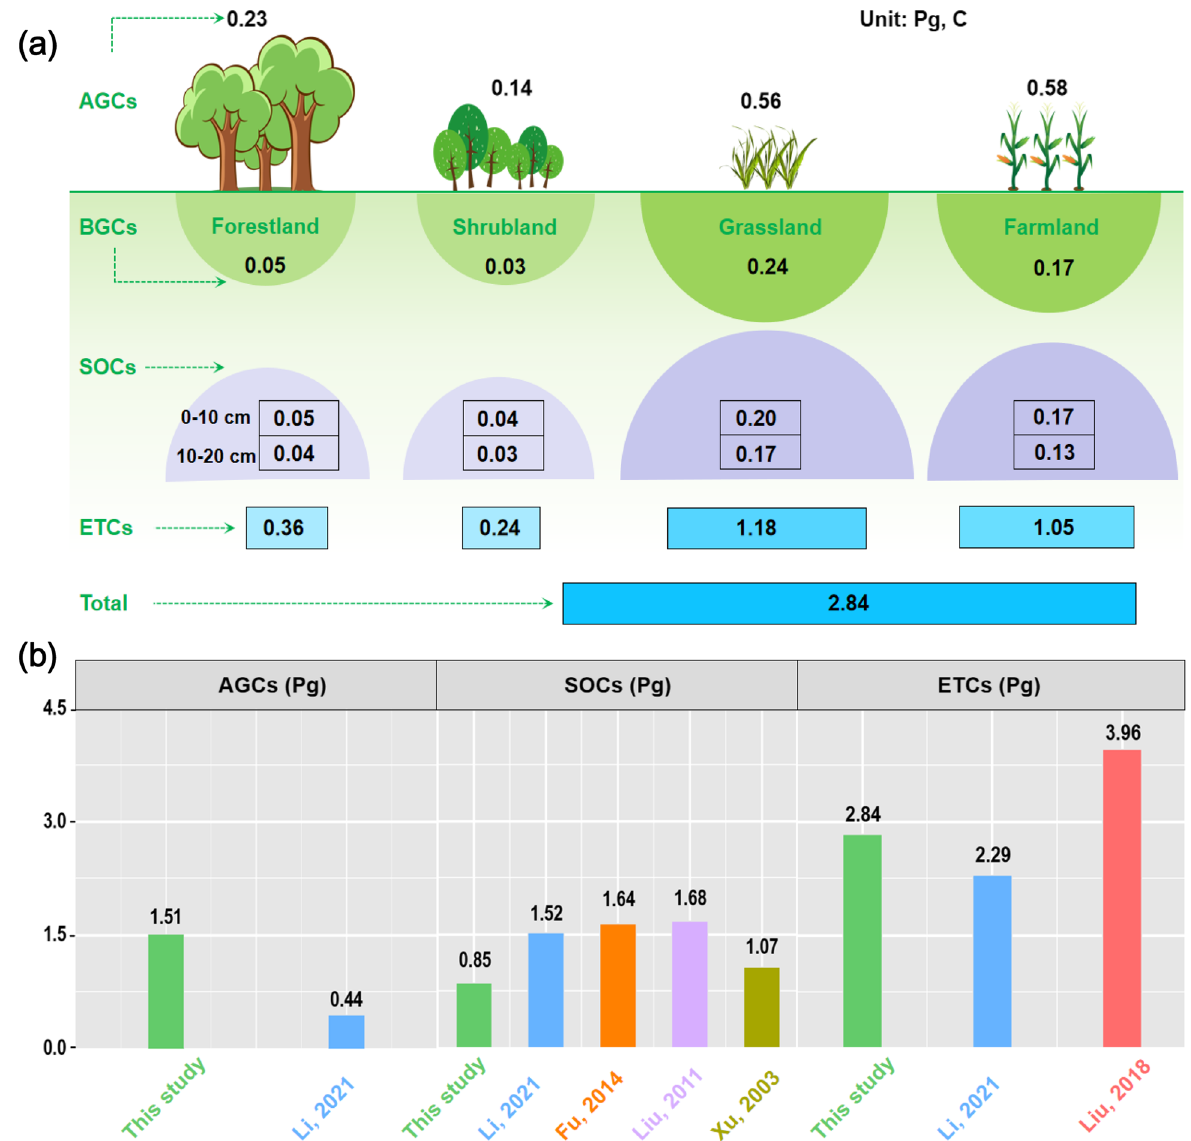
Fig. 4 Summary of the ecosystem C stocks across the Loss Plateau of China ( a ). Statistics of C density and stocks in the Loess Plateau and China derived from various studies, compared with our study ( b ). AGCs: above-ground carbon stock; BGCs: below-ground carbon stock; SOCs: soil organic carbon stock; ETCs: ecosystem total carbon